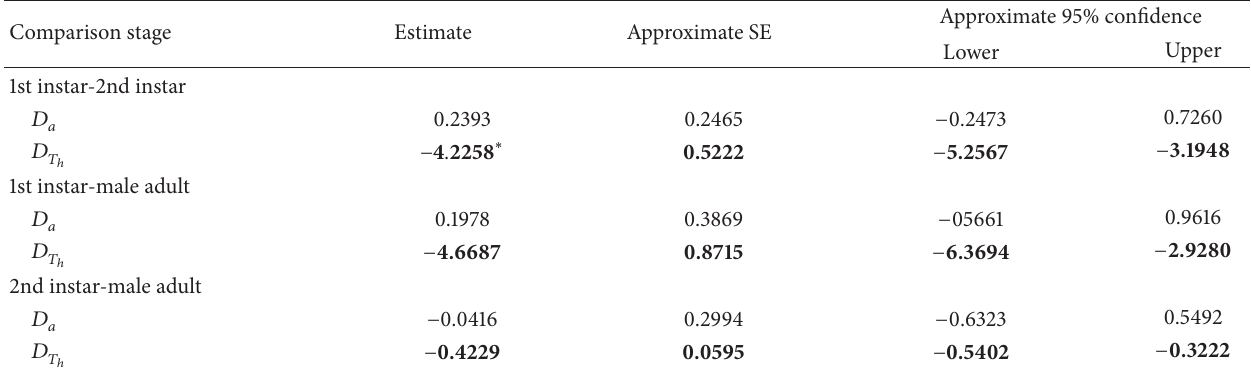
Table 3: Parameters estimated by an equation with an indicator variable for comparing type II functional response parameters of 1st and 2nd instar larvae and males of N. arcuatus .